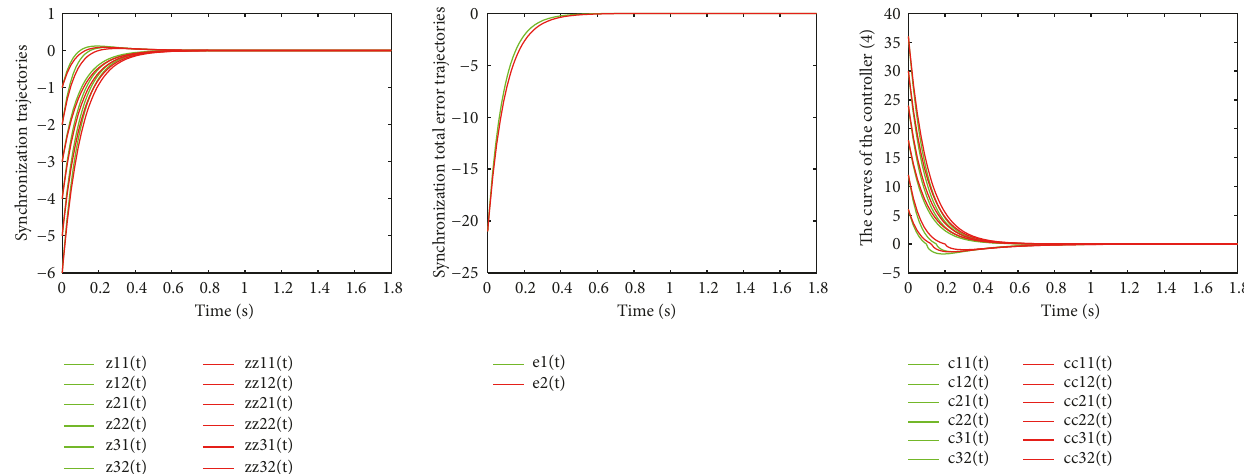
Figure 8: Synchronization trajectories, synchronization total error trajectories of networks (1) and (2) with controller (4) and the curves of controller (4) for Case I-3 of Example